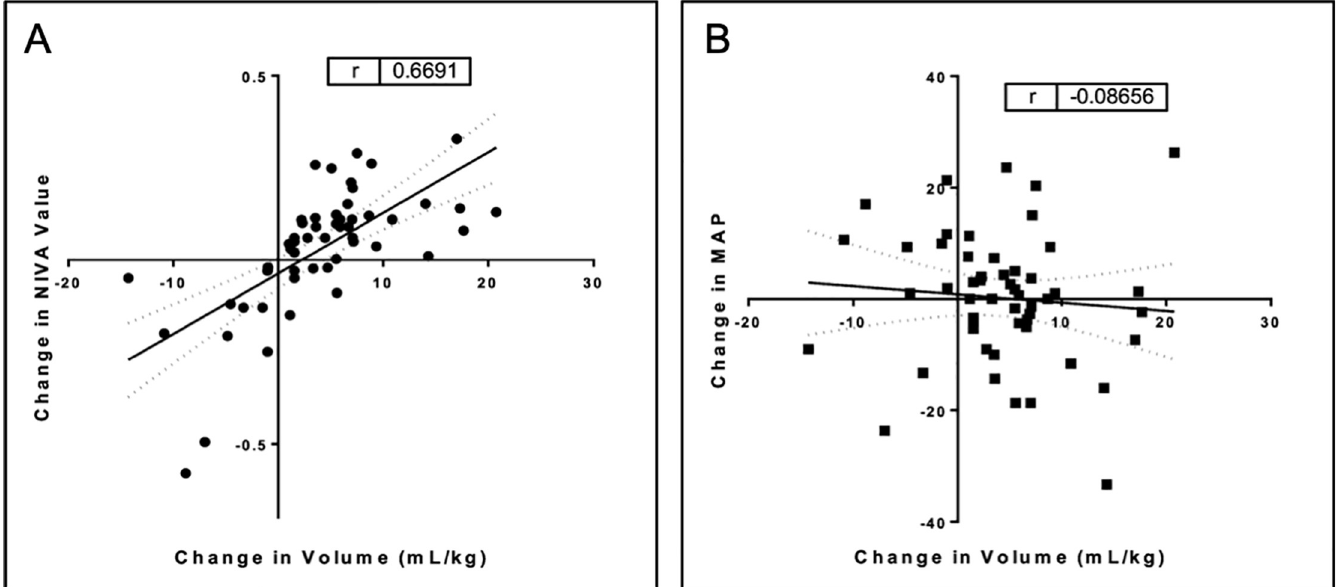
Fig 1. Change in volume (includes fluid/blood administration and estimated blood loss) vs. (A) change in NIVA signal and (B) change in MAP.